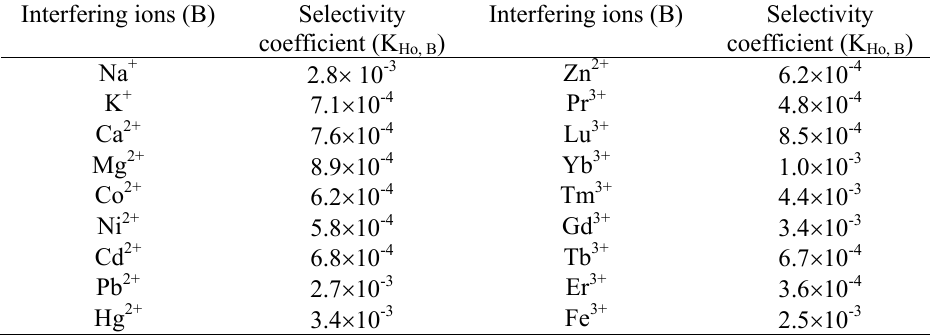
Table 2. Selectivity coefficients of various interfering ions (B) Interfering ions